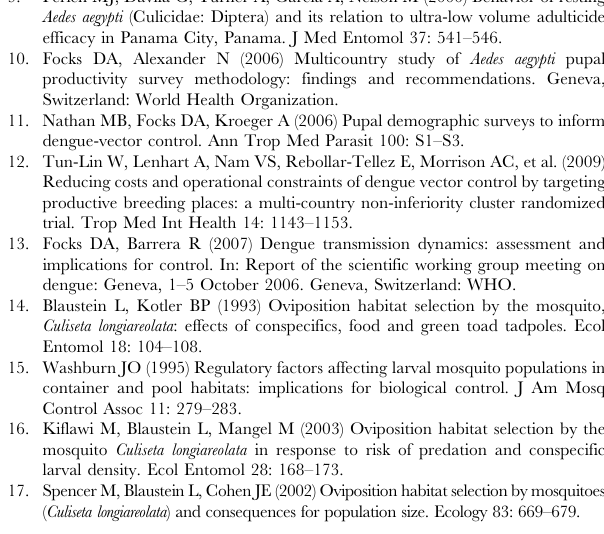
Table S1 Air temperature, relative humidity, and water temperature at households included in field study (14 of 20 houses). All data were recorded outdoors. Trial 1 was conducted during August 2008 and trial 2 during mid-September to mid-October 2008. * Data missing due to logger malfunction. Table S2 Dates and meteorological data for semi-field experiment examining oviposition patterns of individual females within an enclosure. All trials took place during 2008 inside the same enclosure. a Pre-intervention scenario (two large unmanaged containers and six small manually filled containers available within enclosure). b Post-intervention scenario (eight small manually filled containers available within enclosure). c Data missing due to logger